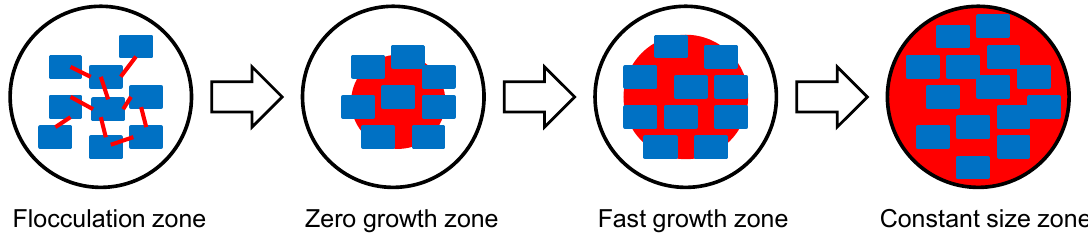
Figure 7. Schematic illustration of the four steps mechanism of spherical agglomeration growth.